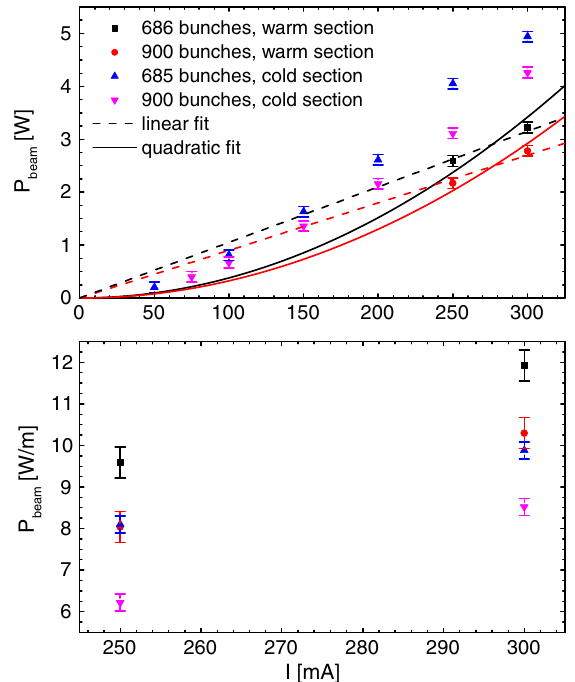
FIG. 6. Comparison between the beam heat load in the warm and in the cold section. Top: measured beam heat load. Bottom: beam heat load scaled by the length of each section. The dashed lines in the upper plot indicate a linear dependence on the beam ∝ I , while the solid lines a quadratic one current P beam ∝ I 2 P beam